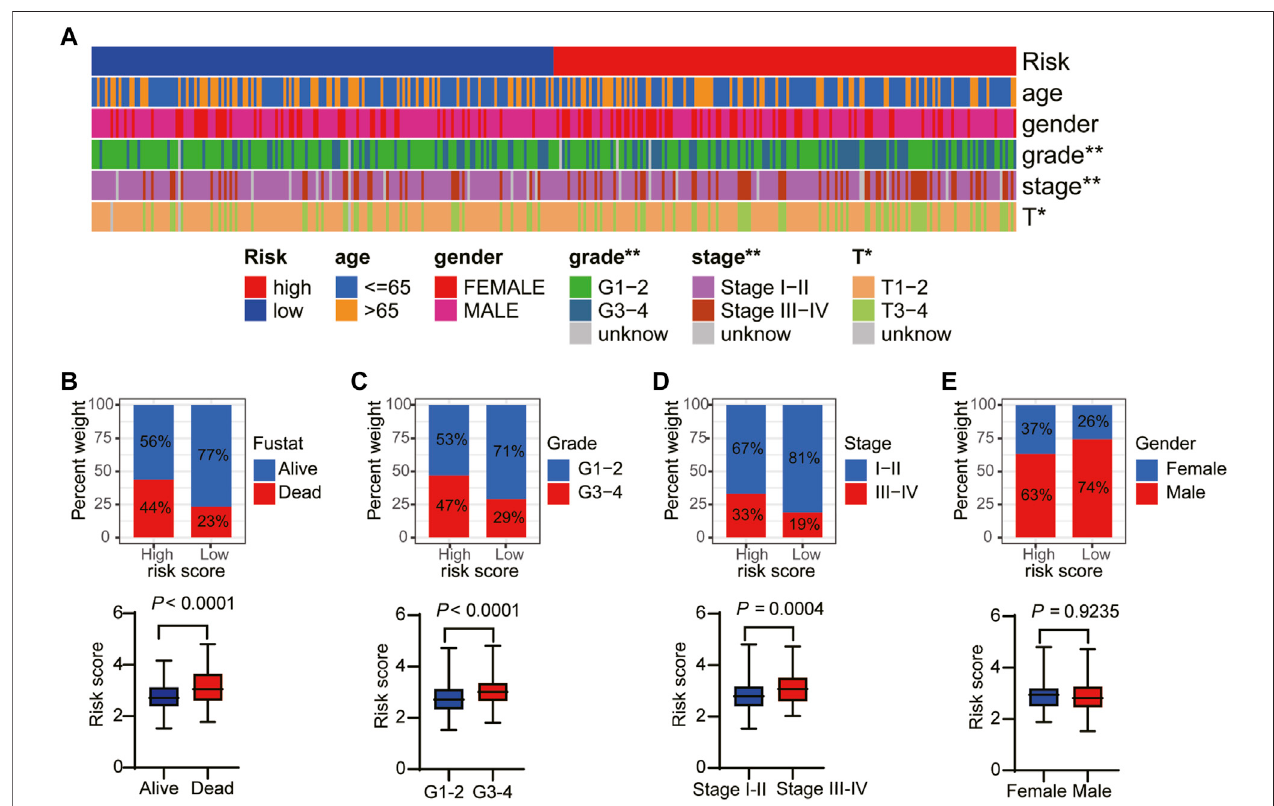
FIGURE6| Therelationshipbetweentheriskscoreandclinicalfactors. (A) Theoverviewofthecorrespondencebetweennecroptosis-relatedprognosticandother features of HCC patients. The proportion of patients with alive and death (B) , G1 – G2 and G3 – G4 (C) , stage I – II and III – IV (D) , and female and male (E) .